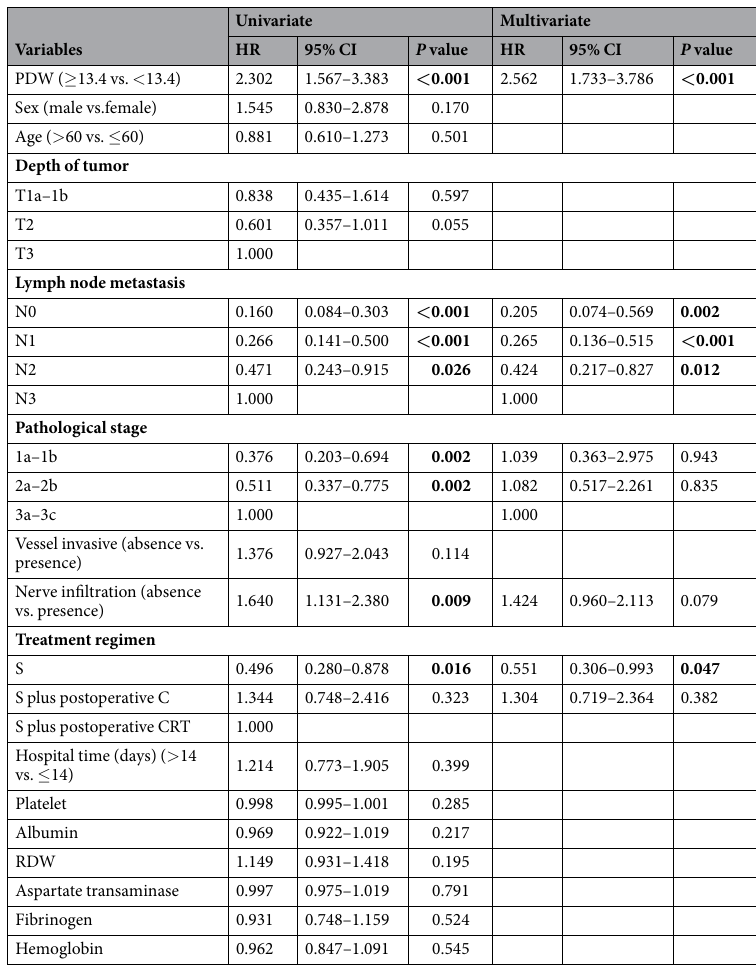
Table 5. Disease-free survival analyses according to preoperative PDW in 495 patients with ESCC. Abbreviations: S, surgery; C, chemotherapy; CRT, chemoradiotherapy; PDW, platelet distribution width; RDW, red cell distribution